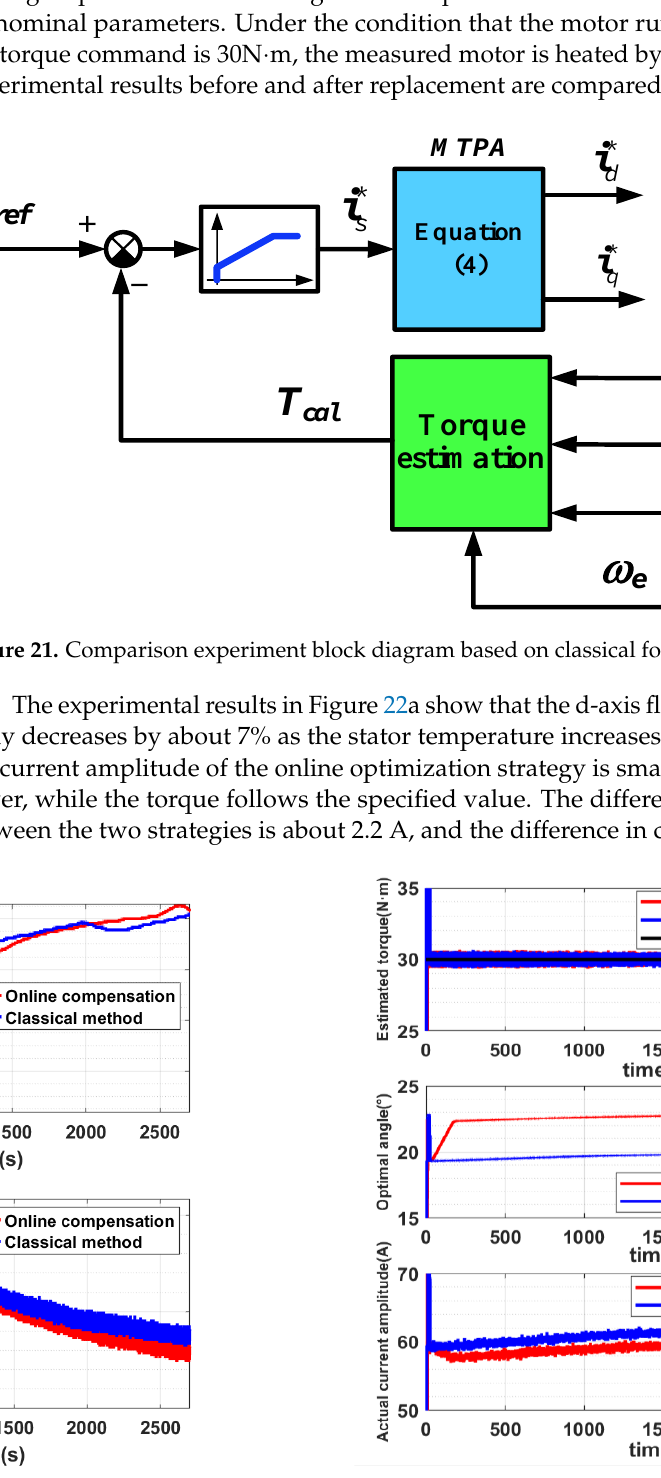
Figure 20. Error of wide temperature torque model.